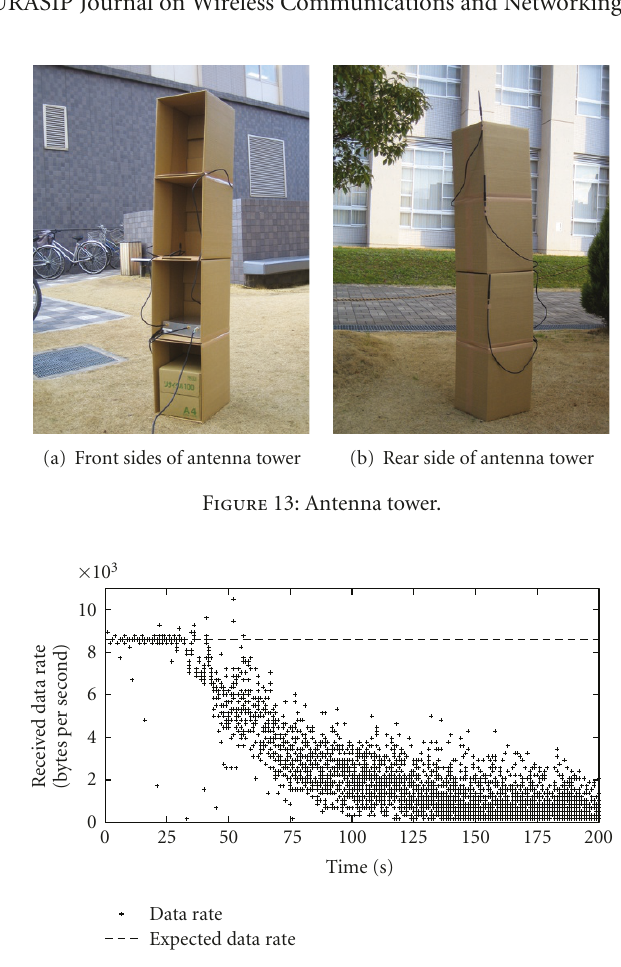
Figure 14: Data reception rate per session at node D.